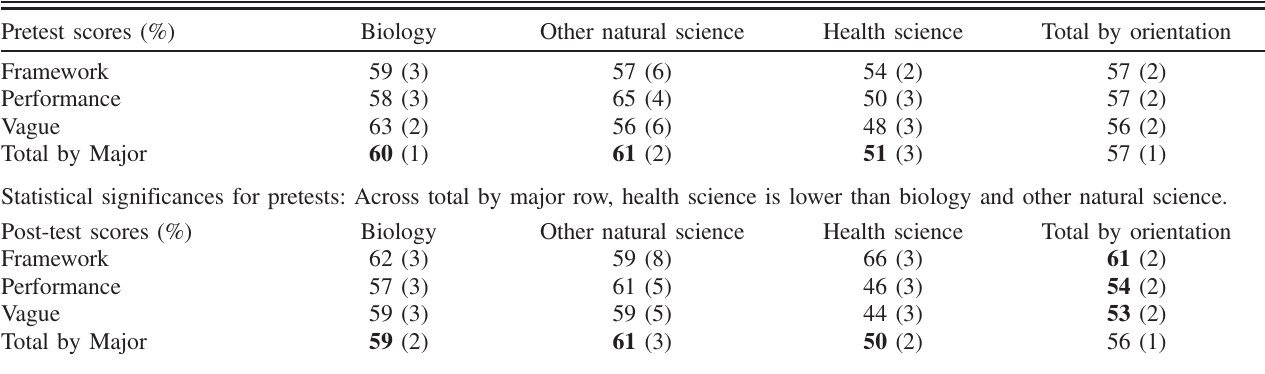
TABLE IV. Average overall CLASS pretest scores, post-test scores, and gains for students, by major and by orientation, in terms of percentage of answers that are expertlike. See Table I for sample sizes. Standard errors are presented in parentheses next to reported values [e.g., “ ð 3 Þ ” ¼ þ = − 3%